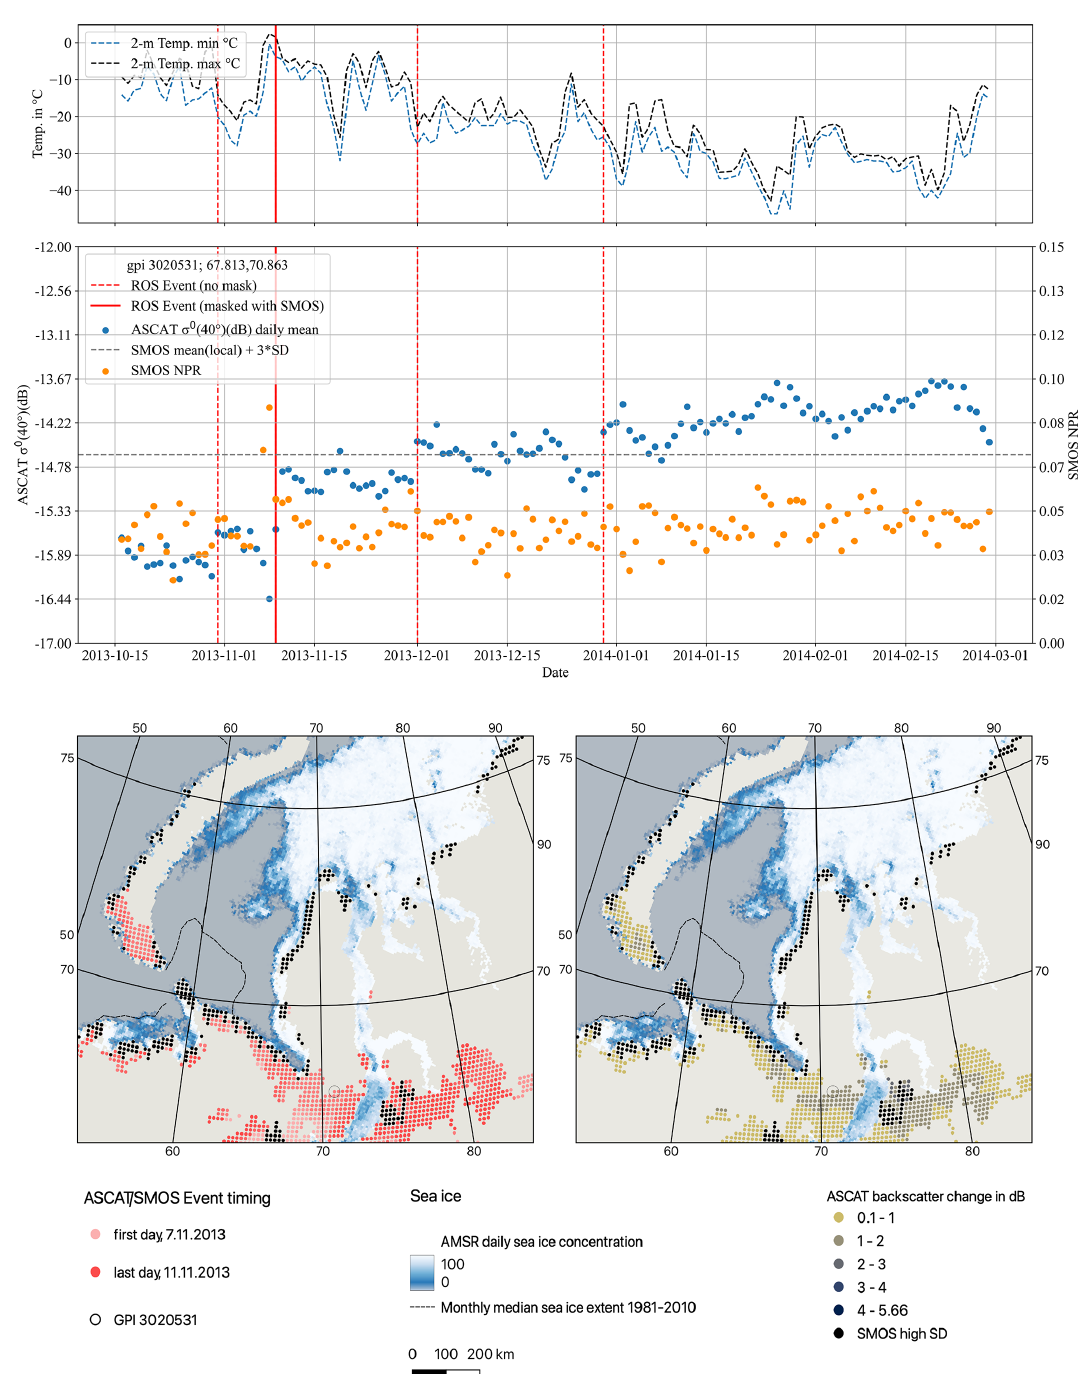
Figure 13. Example for a grid point on southern Yamal documenting the 2013 event (as described in Forbes et al., 2016). Top: time series of ASCAT backscatter and SMOS NPR. Air temperature data have been obtained from reanalysis data (ERA5). Only the detected event around 10 November has been caused by an ROS event (with a high SMOS NPR at the same time). All other events correspond to temperature drops. For location see black circle in bottom panel. Bottom: grid points with an event in November 2013 and sea ice concentration (9 November 2013 and long-term November average; source: University of Bremen; Spreen et al., 2008). Left: event date by grid point; right: ASCAT (cid:49)σ 0